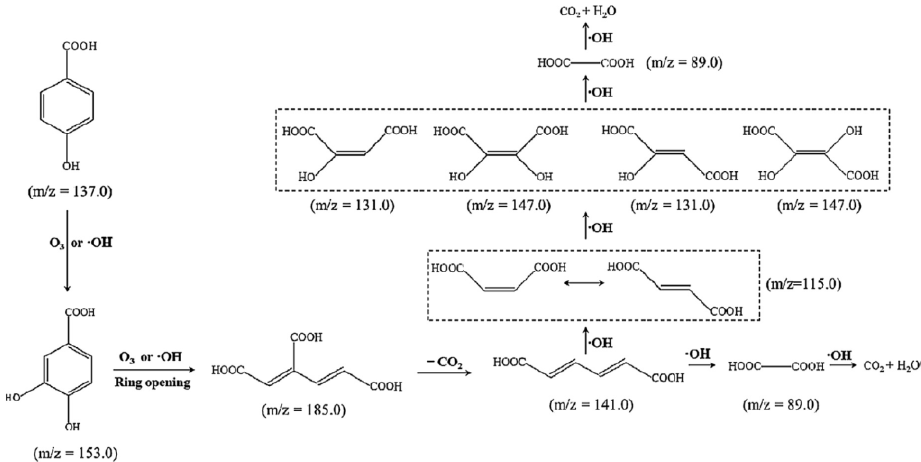
Figure 11. Proposed mechanism for PHBA mineralization in Vis/O 3 /PGCN-3. Reproduced with permission from Ref. [62]. Copyright 2016 Elsevier.